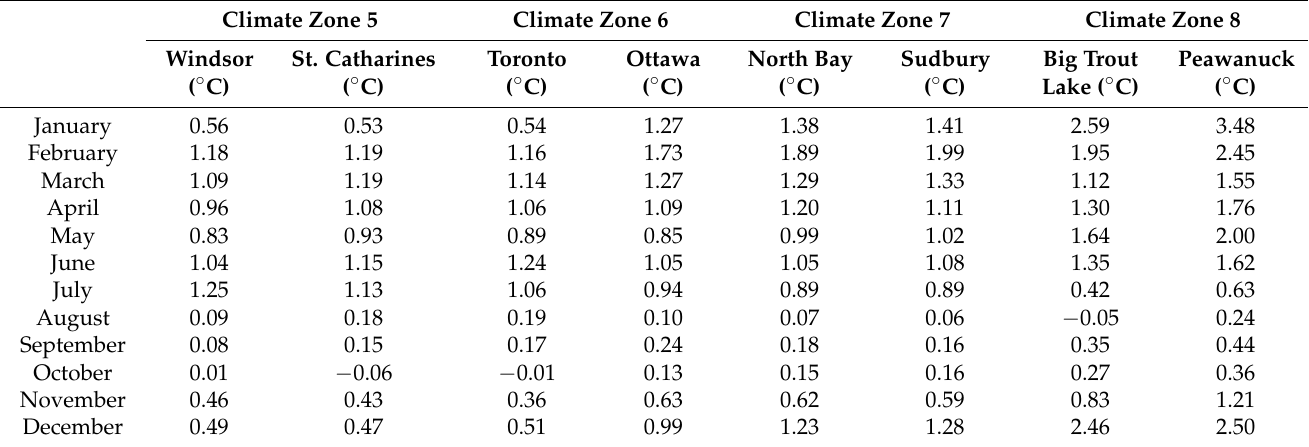
Table 5. Monthly temperature difference between 2020–2044 & 2024–2069 for the 8 cities.